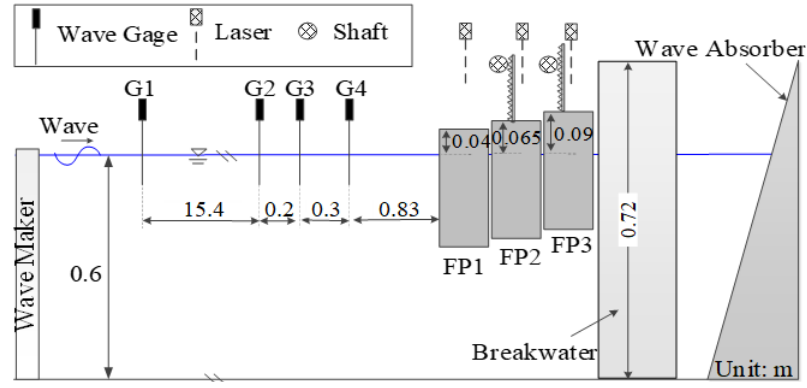
Figure 3. A sketch of the experimental